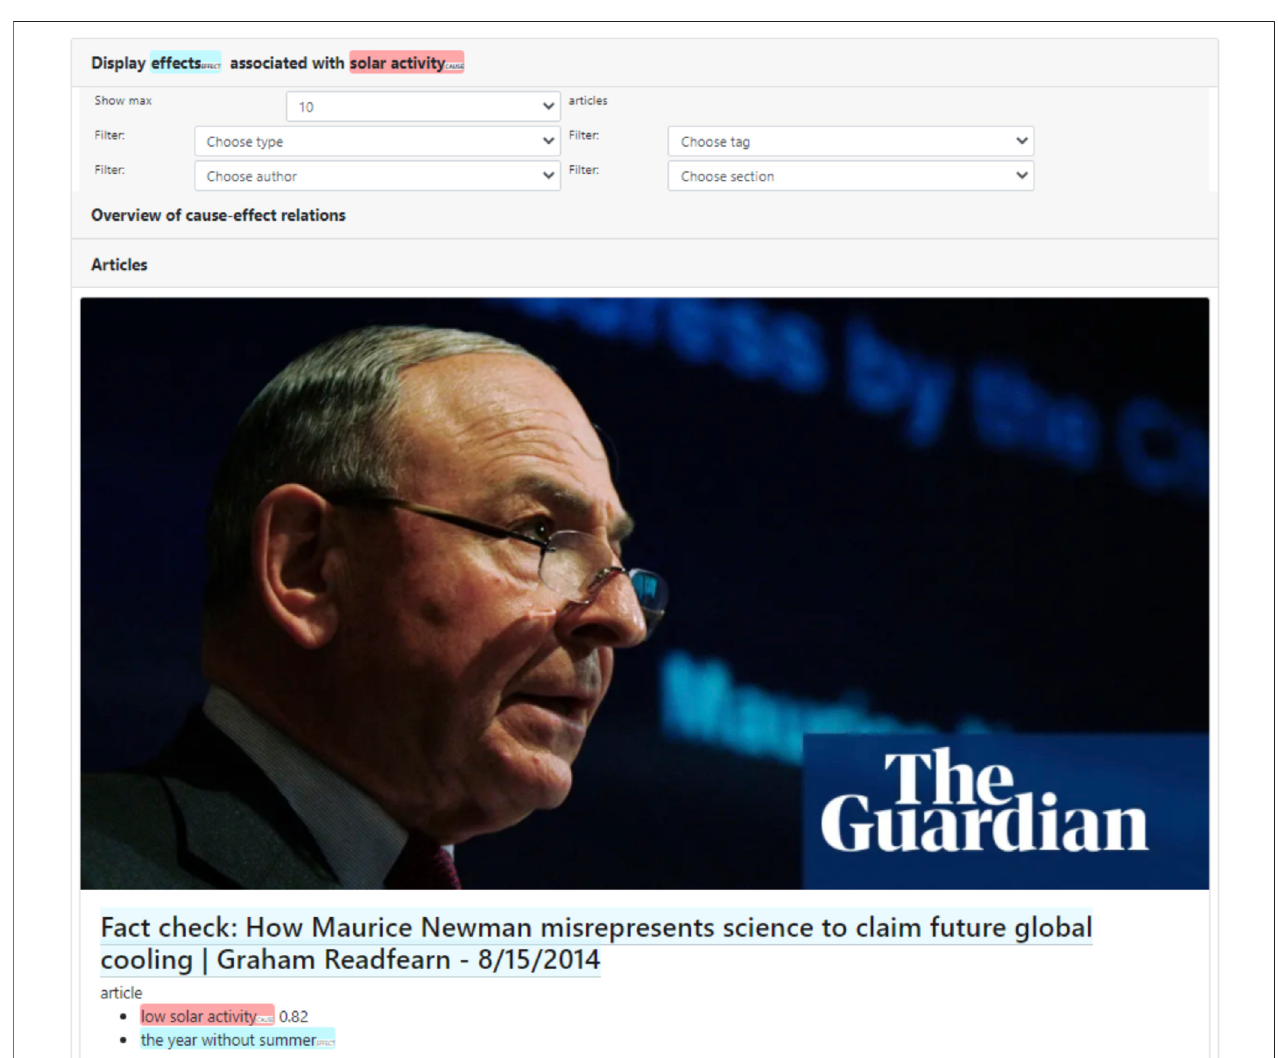
FIGURE 5 | Detail of retrieved articles containing alternative “ effect ” frame elements for the “ cause ” frame element “ solar activity. ” The retrieved article positions debates about the effects of “ (low) solar activity ” in the context of fact-checking and misrepresentations of science.